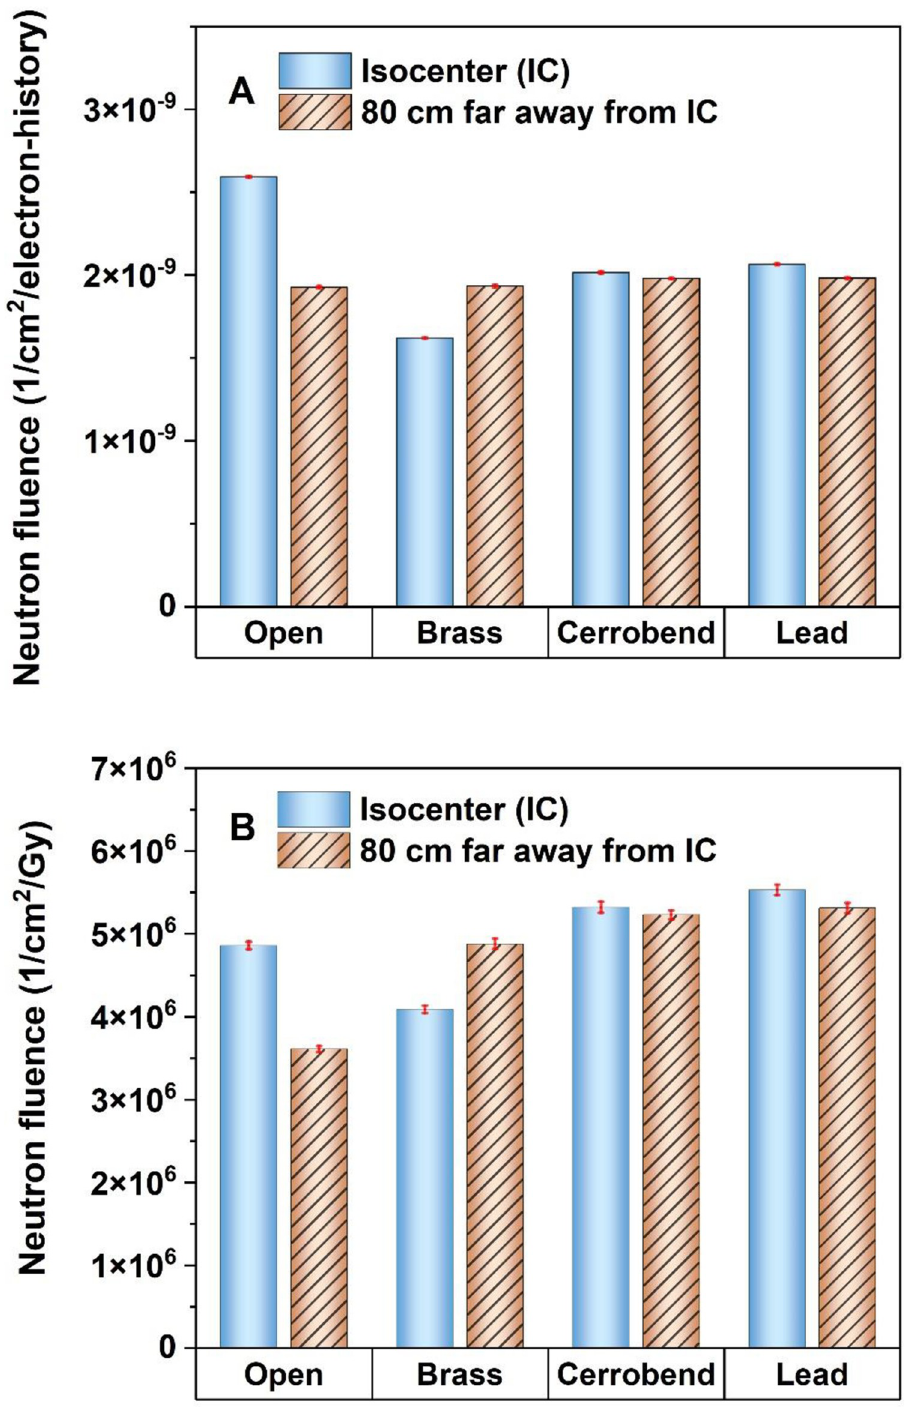
Fig 3. Comparison of neutron fluence at the patient table between conventional radiotherapy (open field) and grid radiotherapy (using different grids made of brass, cerrobend, and lead). The comparison was based on 1 electron history impinging on the Bremsstrahlung target (A) and 1 Gy photon dose delivered to d max (B).